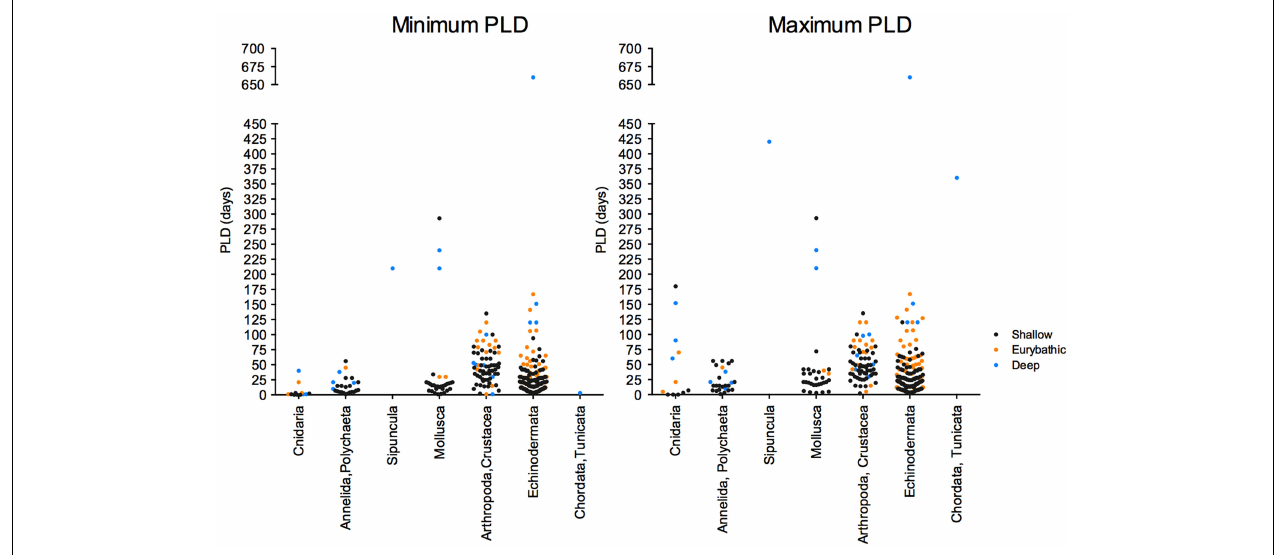
FIGURE 4 | Minimum (left) and maximum (right) PLD values available for shallow, eurybathic and deep-sea species of the different invertebrate